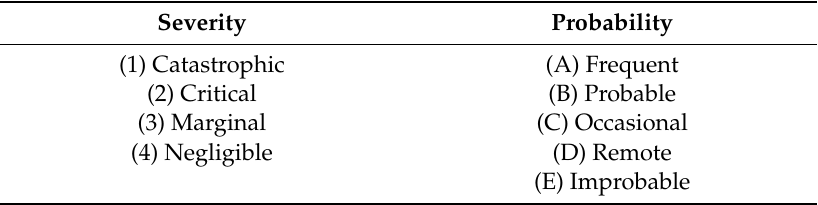
Table 3. Mishap risk indices according to MIL-STD-882D